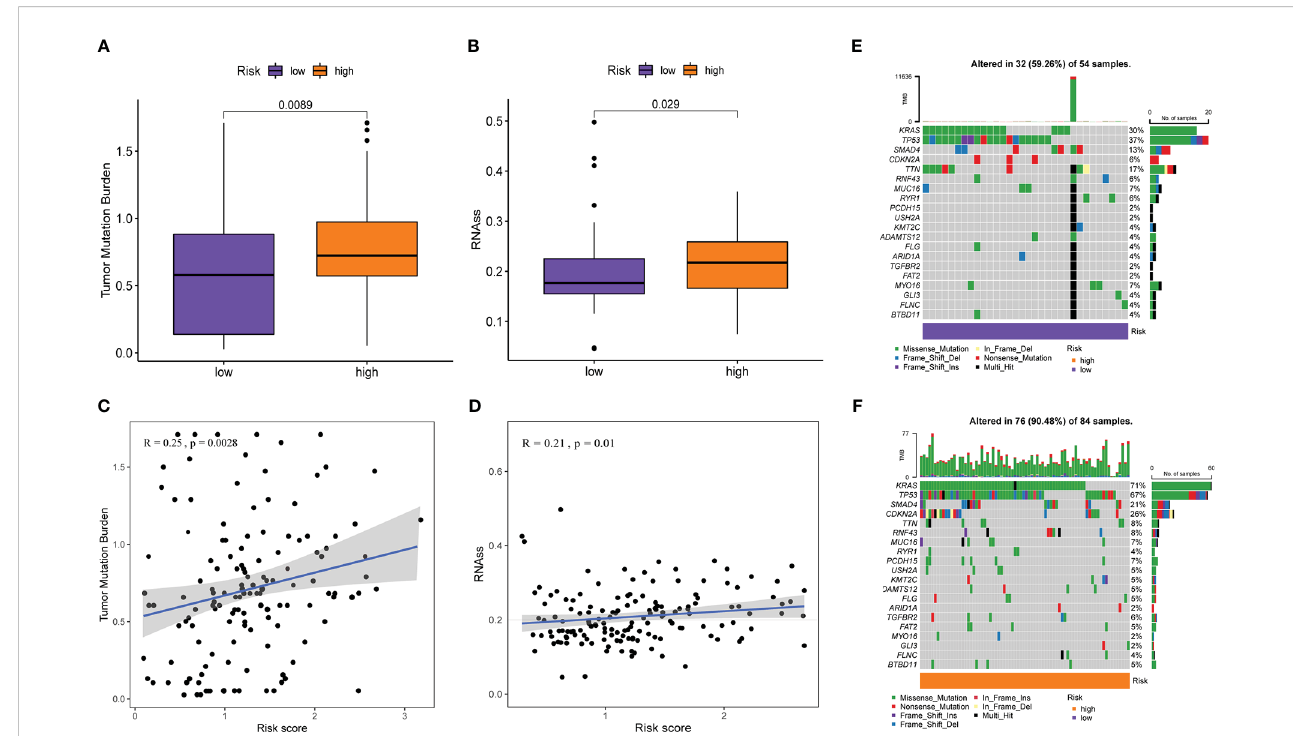
FIGURE 9 Prediction of PMSRPS on other measures related to immunotherapy response. (A, B) Comparison of tumor mutational burden(TMB) (A) and RNA stemness scores (RNAss) (B) between the high- and low-risk groups. (C, D) Correlation of risk score with TMB (C) and RNAss (D) . (E, F) Changes in gene mutation frequency and mutation type from the low-risk group (E) to the high-risk group (F)